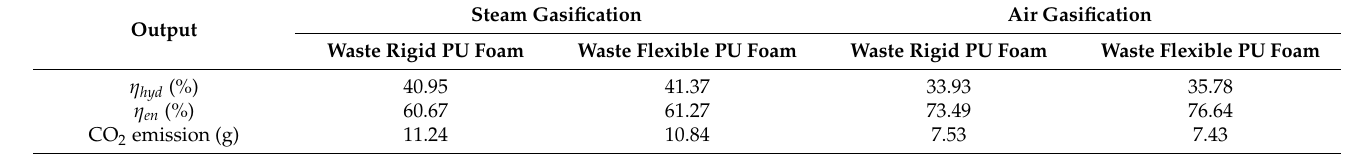
Table 3. Performance comparison of steam and air gasification of waste flexible and rigid PU